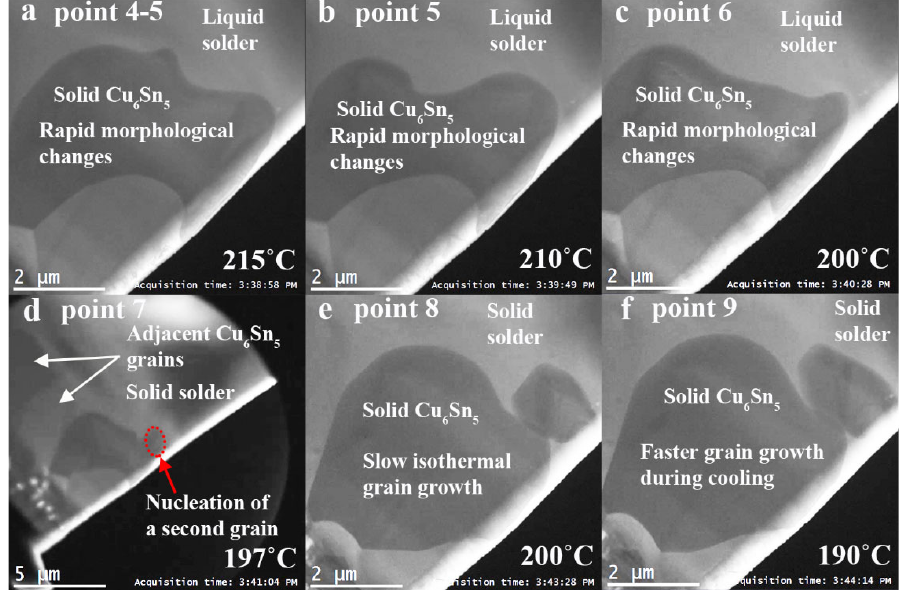
Figure 4. Snapshots of the heating experiment ( a ) between point 4 and 5, ( b ) at point 5, ( c ) point 6, ( d ) point 7 (zoomed out to provide a view of the area surrounding the selected grain), ( e ) point 8 and ( f ) point 9.